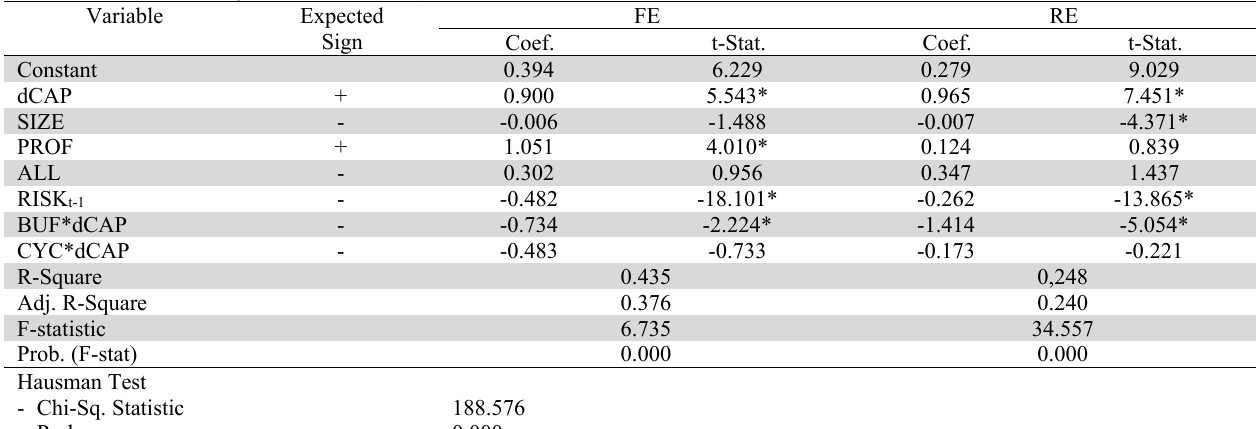
The Results of Risk Adjustments (dRISK)